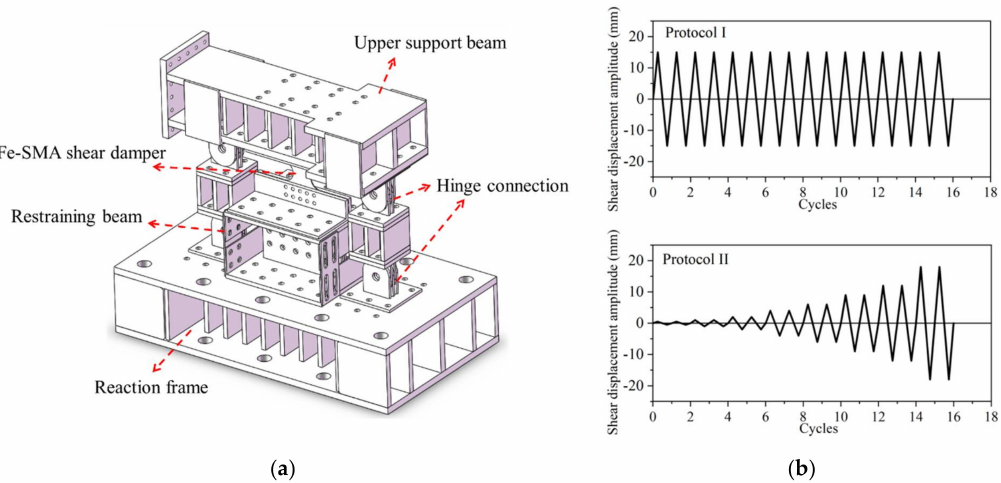
Figure 17. LaboratoryexperimentofFe-SMA-basedBRS:( a )illustrationoftestsetup;and( b )loadingprotocols.